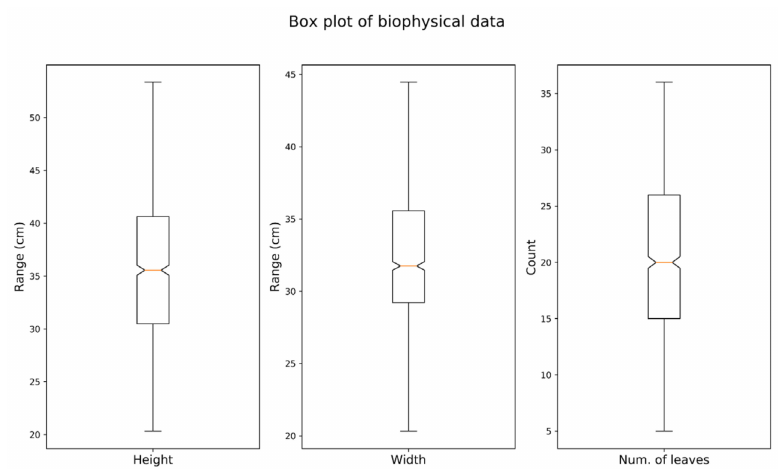
Figure 5. Biophysical boxplot of height, width, and number of leaves